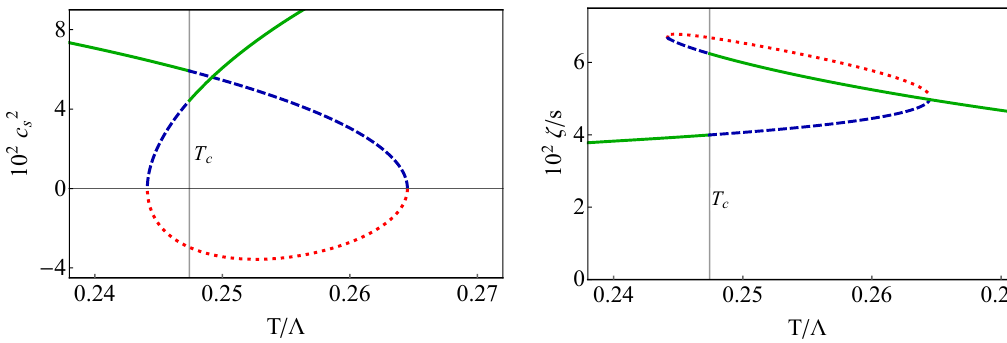
Figure 2 . (Left) Speed of sound squared versus temperature for the gauge theory dual to (2.1). The color coding is as in (cid:12)gure 1. (Right) The ratio of the bulk viscosity over entropy (cid:16)=s versus temperature. The ratio has a maximum value of max ( (cid:16)=s ) ’ 0 : 0678 at T= (cid:3) ’ 0 :